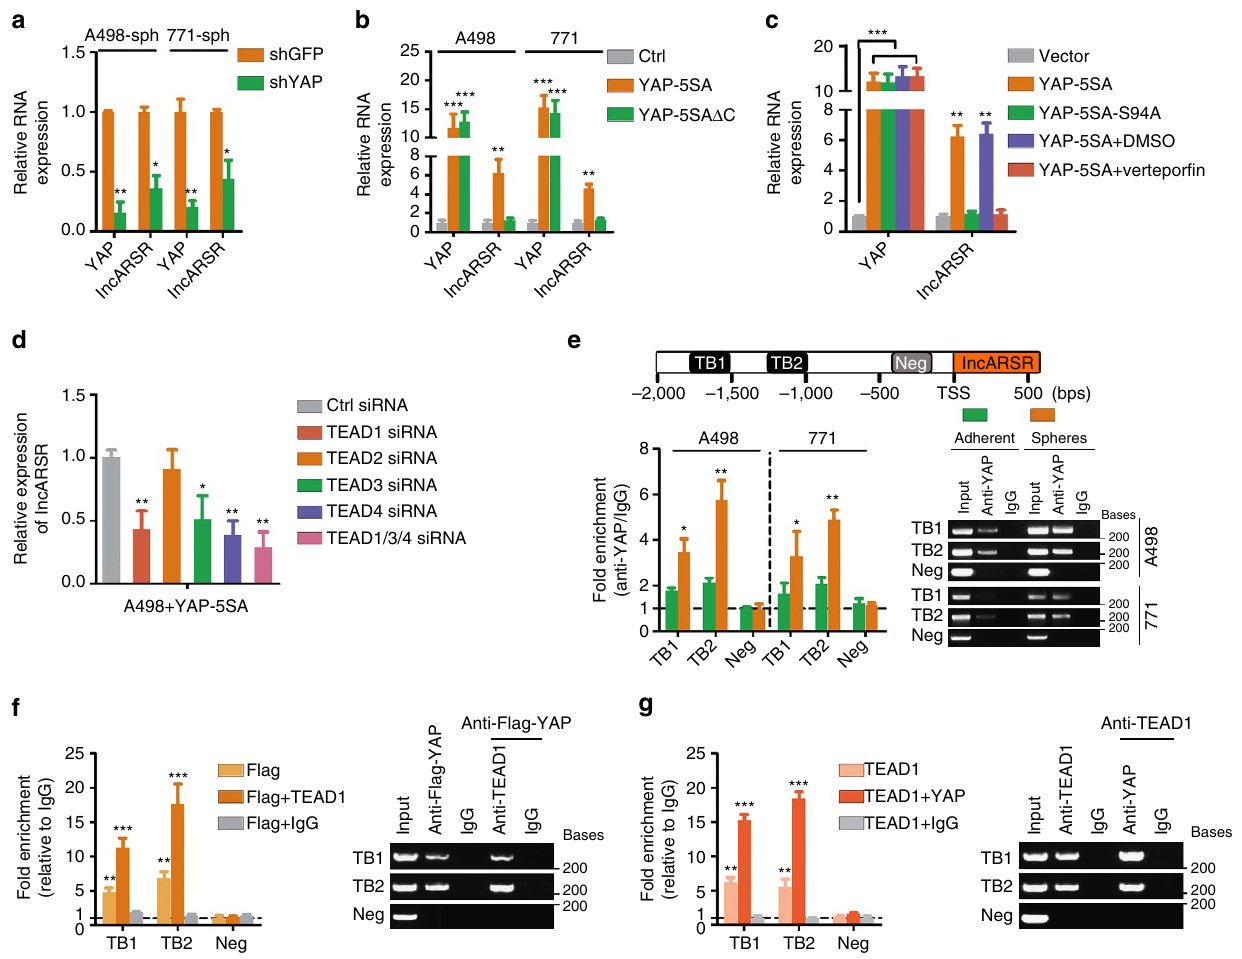
Figure 7 | YAP/TEAD complex transactivates lncARSR. ( a ) qRT–PCR analysis of YAP and lncARSR in RCC spheres transfected with shYAP or shGFP plasmid after 48h ( n ¼ 3). ( b ) qRT–PCR analysis of YAP and lncARSR in RCC cells transfected with YAP-5SA plasmid or YAP-5SA D C plasmid after